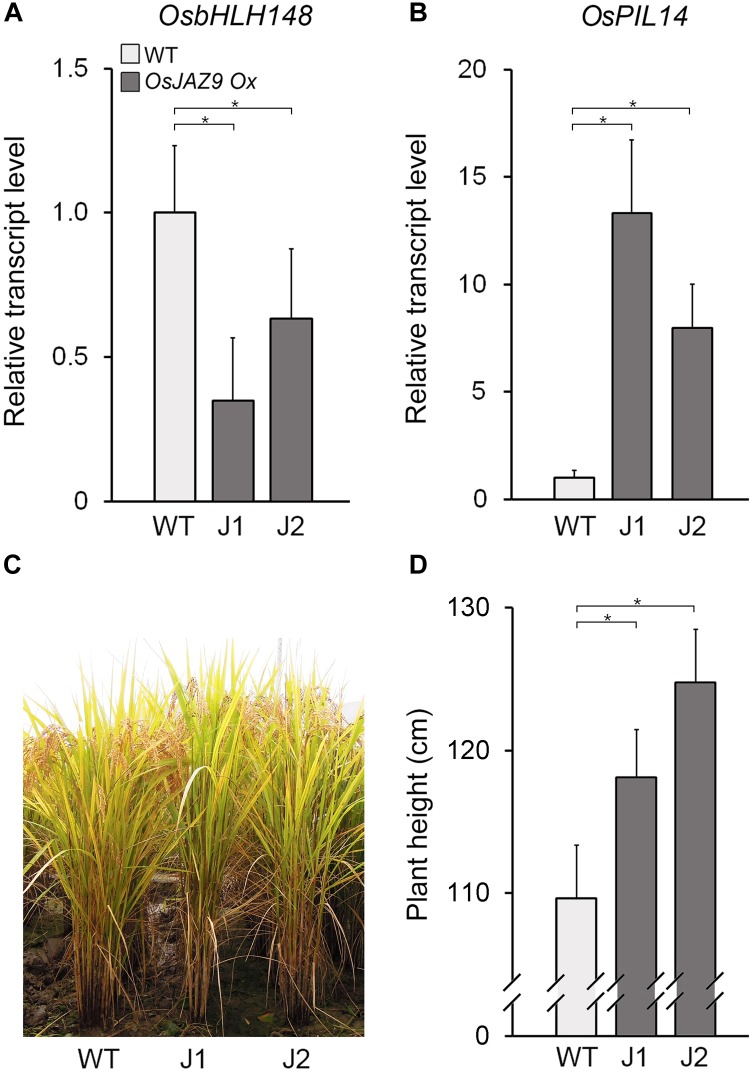
Overexpression of OsJAZ9 promotes the GA response in rice. (A,B) RT-qPCR analysis showing the expression levels of the JA-responsive gene OsbHLH148
(A) and the GA-responsive gene OsPIL14
(B) in the leaf blades of 8-week-old OsJAZ9-overexpressing transgenic rice (PGD1::OsJAZ9). J1 and J2 indicate two independent lines of PGD1::OsJAZ9 plants. Data represent mean values of three biological replicates, and error bars indicate SD. OsTubA2 was used as an internal control and relative expression levels are shown as fold values. (C,D) Growth of PGD1::OsJAZ9 plants grown in field conditions for 25 weeks (C), and quantification of plant height (D) (n > 30). Error bars indicate SD. Asterisks indicate statistically significant differences between the corresponding samples and their control (p-value < 0.01, Student’s t-test).